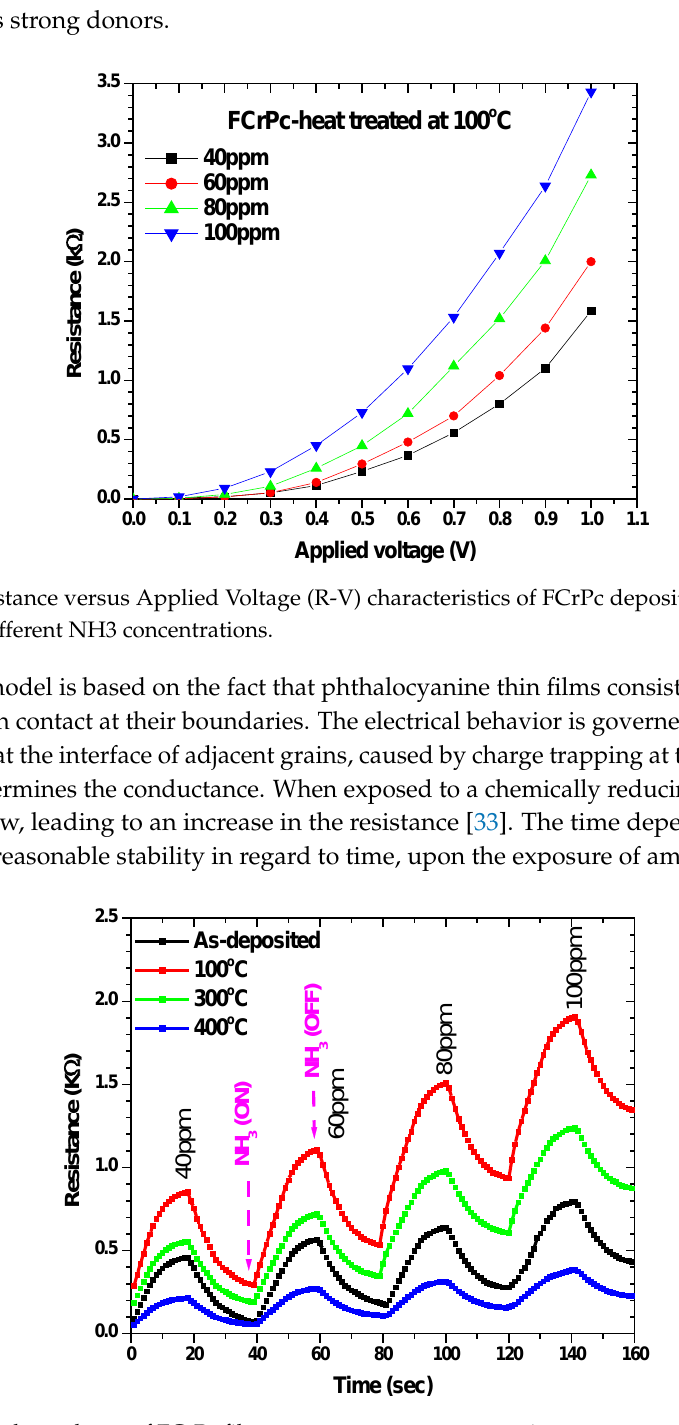
Figure 7. Time dependency of FCrPc films upon exposure to ammonia at concentrations ranging from 40 to 100 ppm.